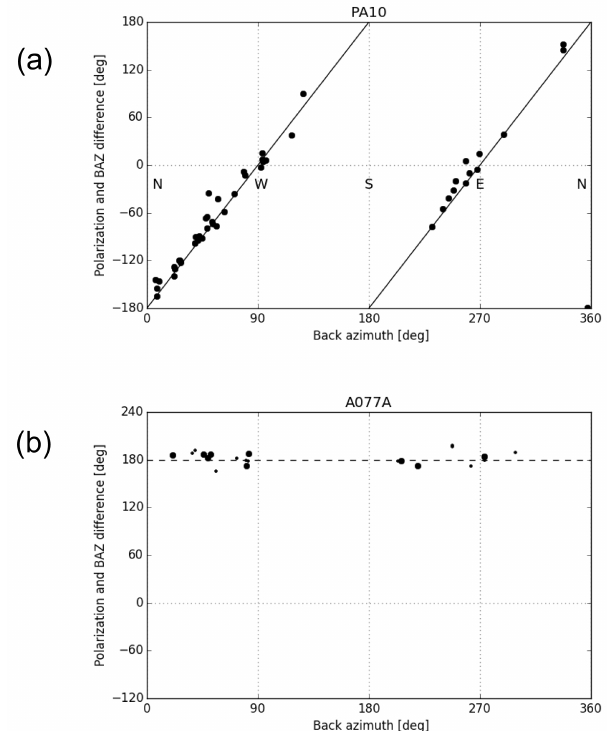
Figure 10. The Rayleigh-wave polarization-angle method show- ing the differences between the Rayleigh-wave polarizations and theoretical back azimuths (BAZ) depending on the BAZ of earth- quakes; (a) linear dependence of the difference identifies the polar- ity reversal of the NS component. The polarization of waves arriving from the east or west is not affected by the reversed NS component. Station PA10 of the PASSEQ experiment 2006–2008 (Wilde-Piórko et al., 2006; Vecsey et al., 2014) is used as an example; (b) the con- stant difference of ∼ 180 ◦ corresponds to the polarity reversal of both horizontal components at the A077A station of